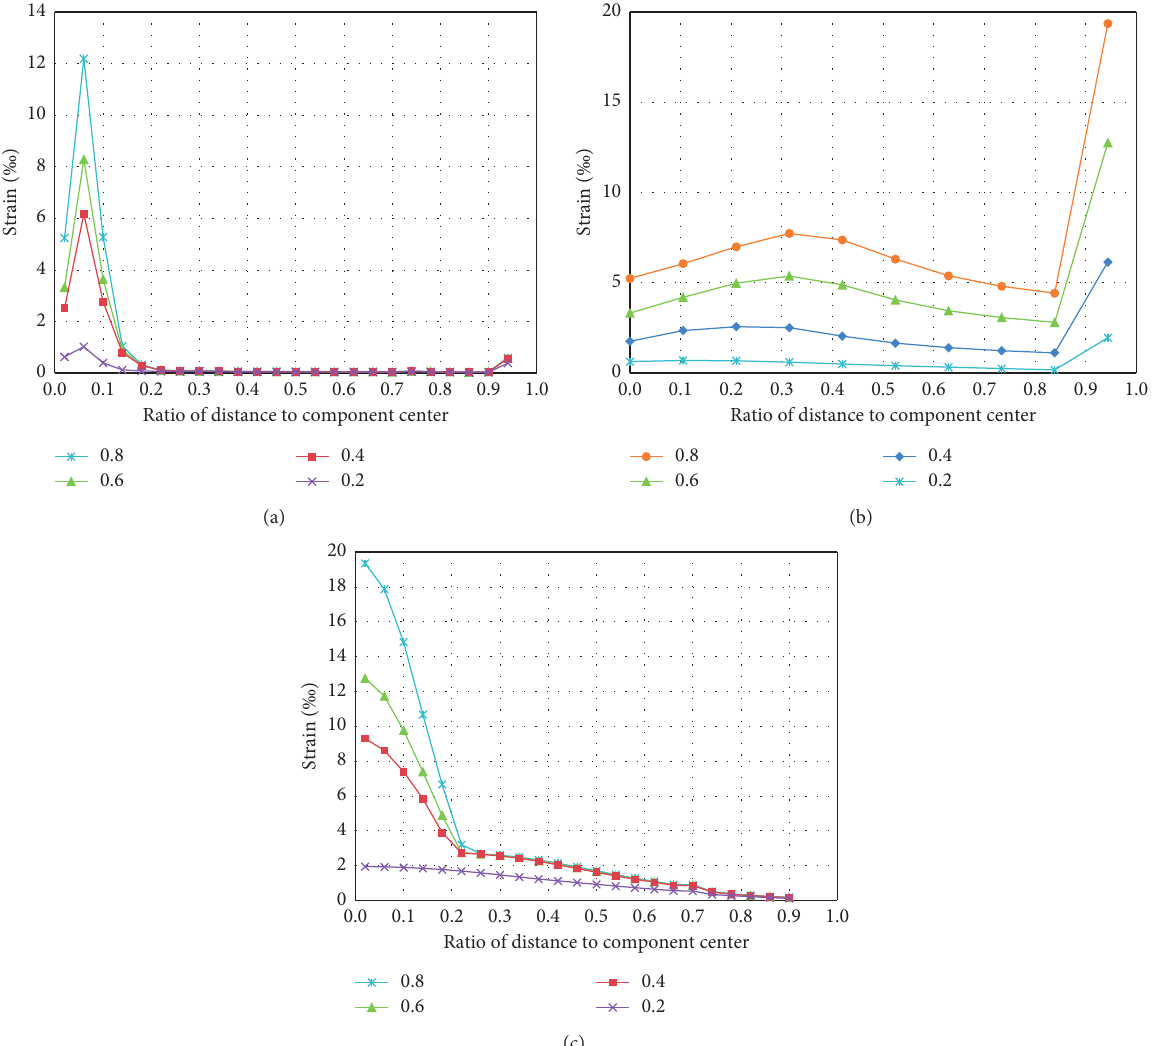
Figure 12: FEM strain curves. (a) Transverse central strain of the FEM. (b) Longitudinal central strain of the FEM. (c) Rib strain of the